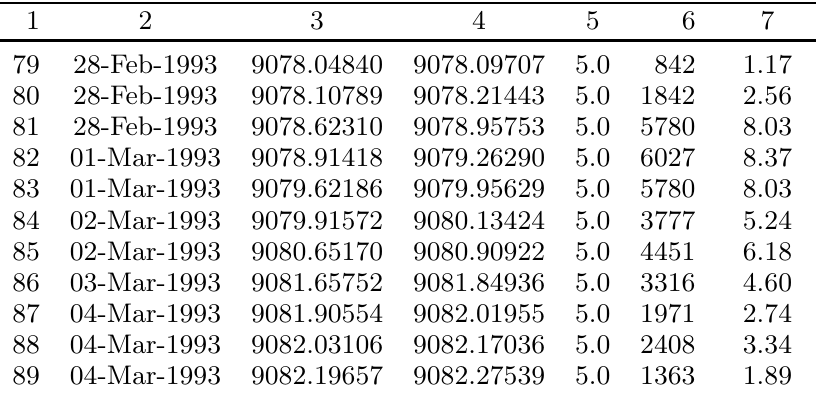
Table 2. Journal of observations of XCov9 (continued).